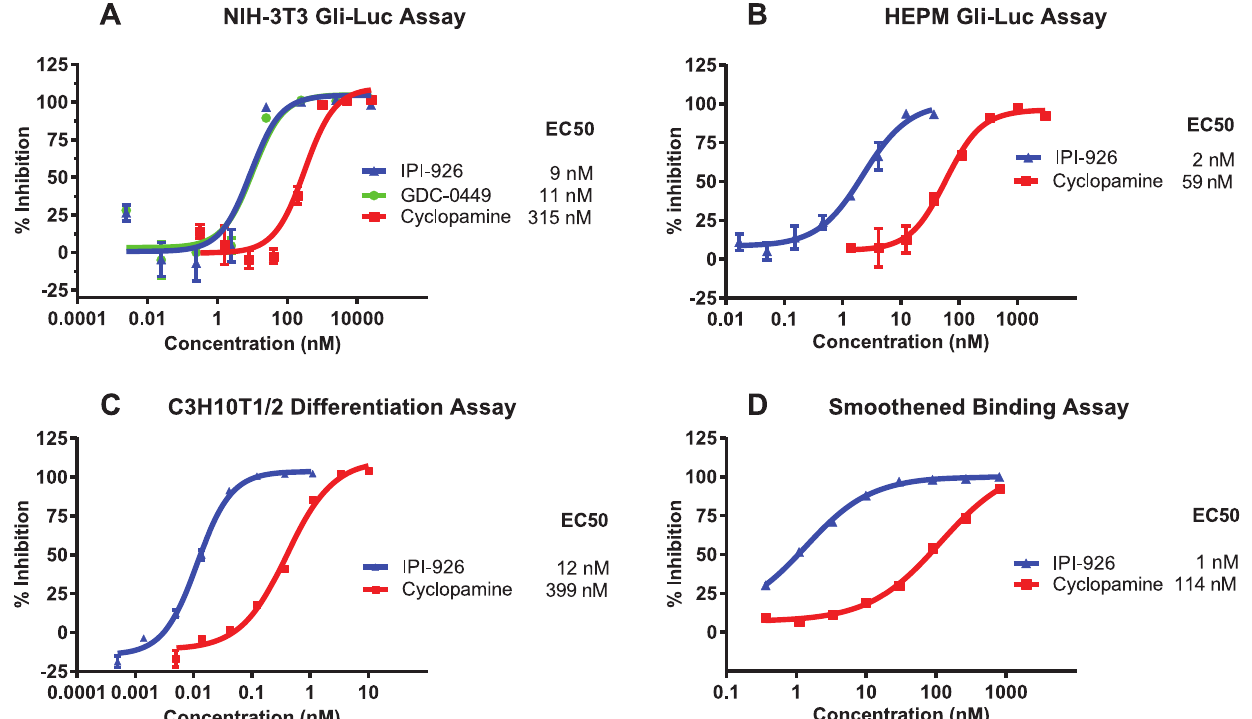
Figure 1. IPI-926 is significantly more potent than cyclopamine in cell based assays. IPI-926 inhibits Shh-induced Gli-Luciferase activity with an EC 50 value of 9 nM in NIH-3T3 cells (A) and 2 nM in HEPM cells (B) compared to cyclopamine which had an EC 50 value of 315 nM in NIH-3T3 cells (A) and 59 nM in HEPM cells (B) (N=3). (C) IPI-926 inhibits alkaline phosphatase production resulting from Shh-induced C3H10T1/2 cell differentiation with an EC 50 value of 12 nM compared to 399 nM for cyclopamine (N=2). (D) IPI-926 inhibits the binding of BODIPY-labeled cyclopamine to C3H10T1/2 cells overexpressing wild-type human Smo with an EC 50 value of 1 nM compared to an EC 50 value of 114 nM for unlabeled